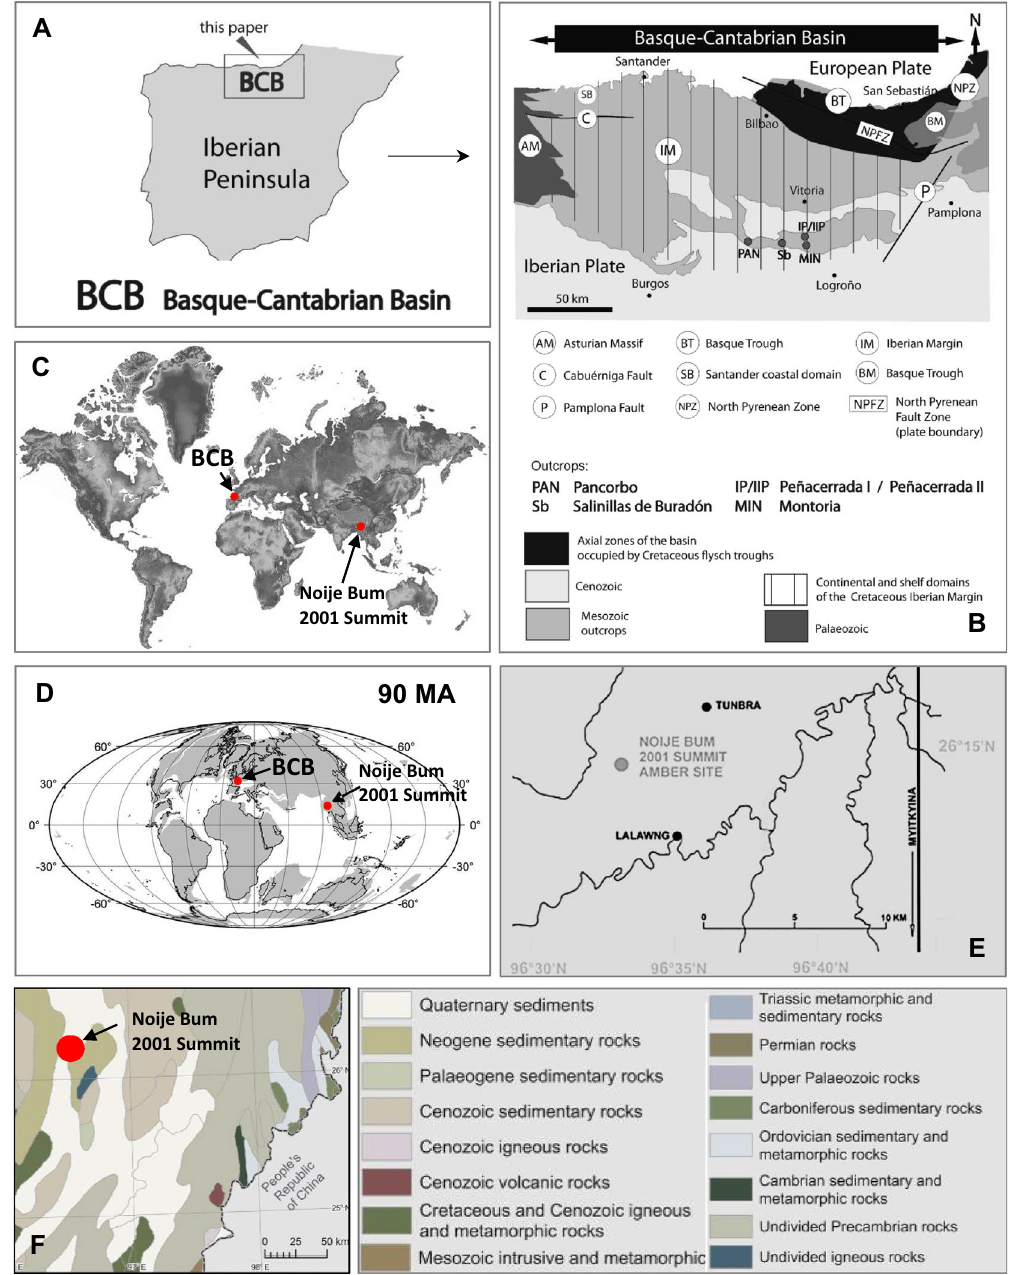
Figure 1. Maps with the position of Spanish and Kachin amber deposits localities. ( A ) Geographical setting of the studied section of Spanish amber deposits; ( B ) Geological setting with location of the studied section of Spanish amber deposits (after Barrón et al. 21 , modified); ( C ) Spanish and Kachin amber deposits localities; ( D ) Spanish and Kachin amber deposits localities in the Cretaceous; ( E ) Location of recent amber mining area in the Hukawng Valley, Myitkina Province, Myanmar; ( A ) Geological setting with location of the studied section of Kachin amber deposits. ( E , F ) Compiled from data provided by Kania et al. 22